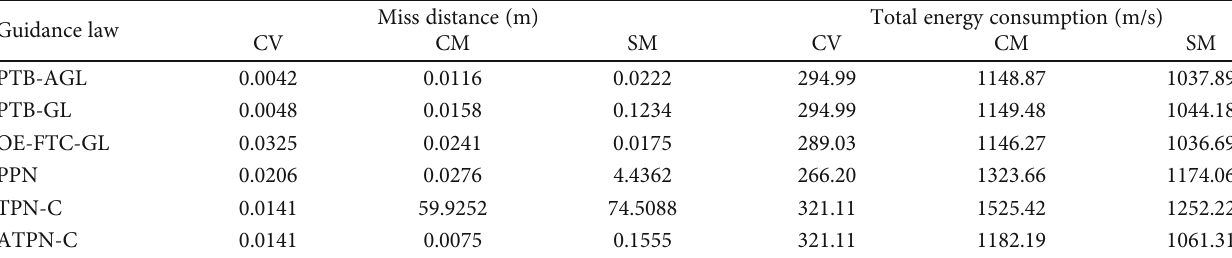
Table 4: Summary of guidance performance — Case